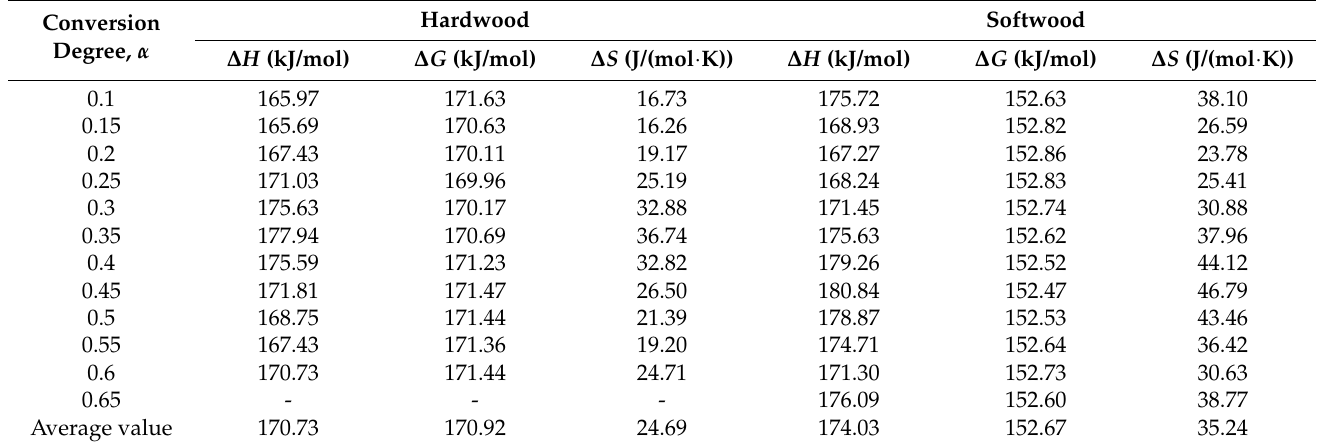
Table 7. H , ∆ G , and ∆ S values of hardwood and softwood at 15